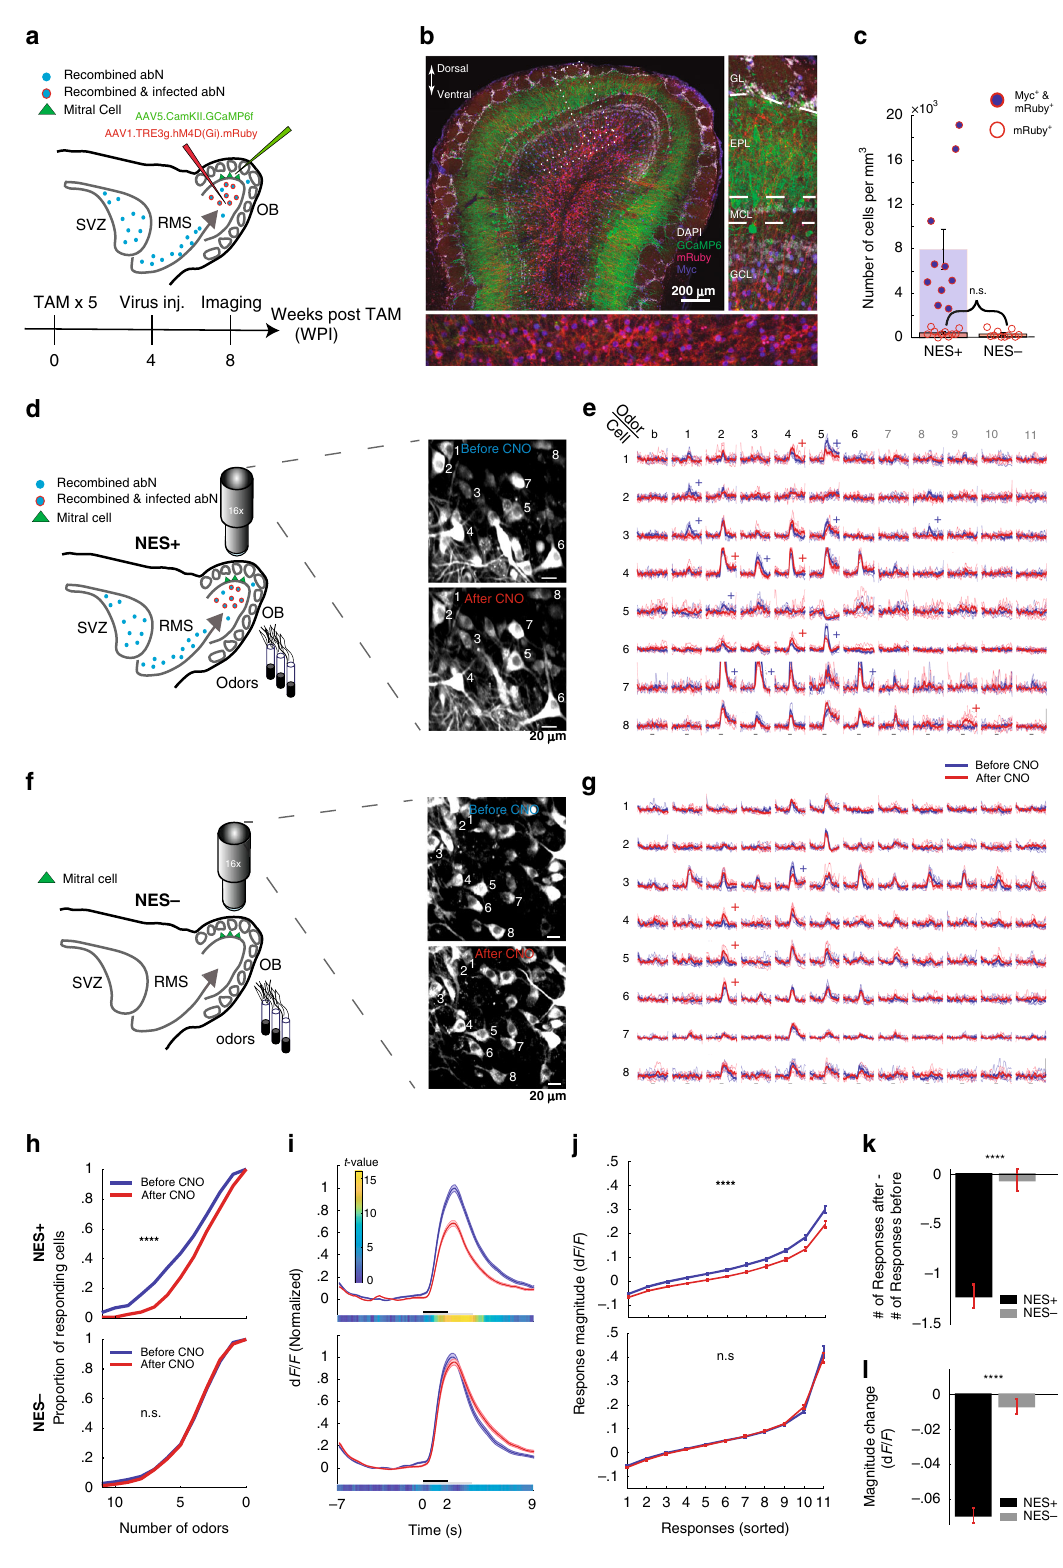
(Fig. 5c, d, f, g). The weakening of the effect by abGCs silencing was also evident as a decrease in the number of responses with signi fi cant changes in response magnitude following CNO injection (Fig. 5e). Similarly, the DCI values (calculated from the population d ′ ) decreased at 12 WPI, and reached control levels by 16 WPI (Fig. 5h, compare with Fig. 4e). Thus, the